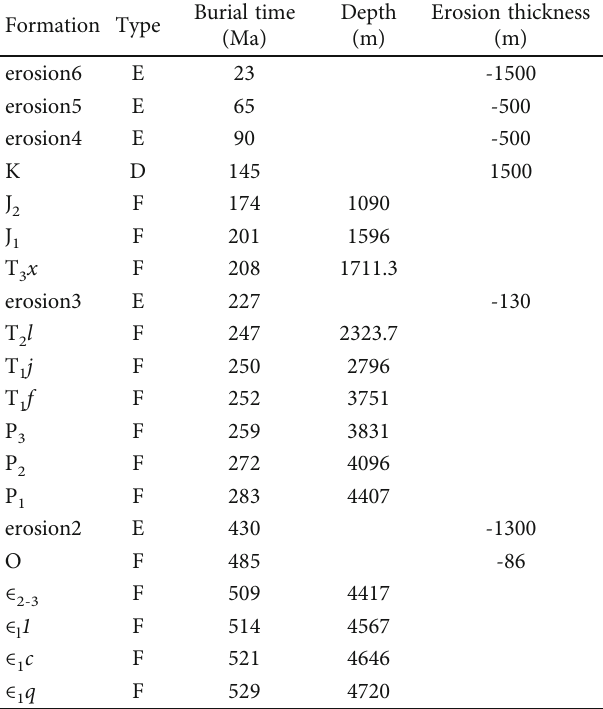
solid+gas)Primary aqueous inclusion filled in quartz from vein (synchronous with solid + gas) Primary aqueous inclusion filled in dolomite from vein (synchronous with solid+gas) Secondary aqueous inclusion filled in dolomite from dissolved pores (synchronous with oil)Primary Oil inclusion filled in dolomite from dissolved pores Primary aqueous inclusion filled in dolomite from dissolved pores (synchronous with Figure 8: The Longwangmiao Formation, Well MX20. Histogram of aqueous inclusion homogenization temperatures.